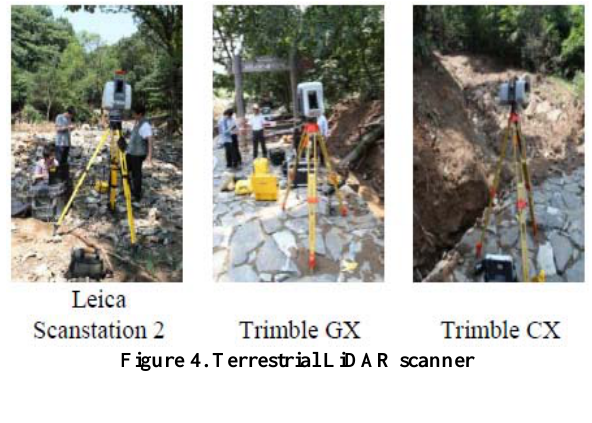
Figure 4. Terrestrial LiDAR scanner